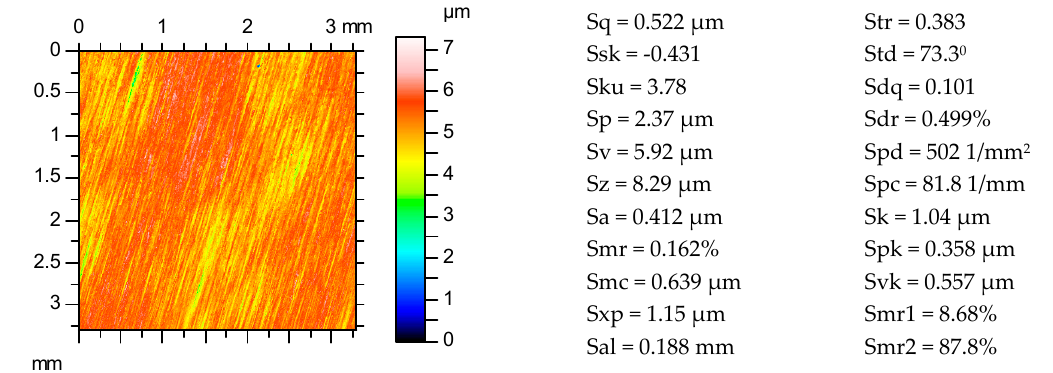
Table 1. Central values, variation units, and coding entry factors for experiment. Central Values of the Entry Factors Units of Variation Encoded Input Factors